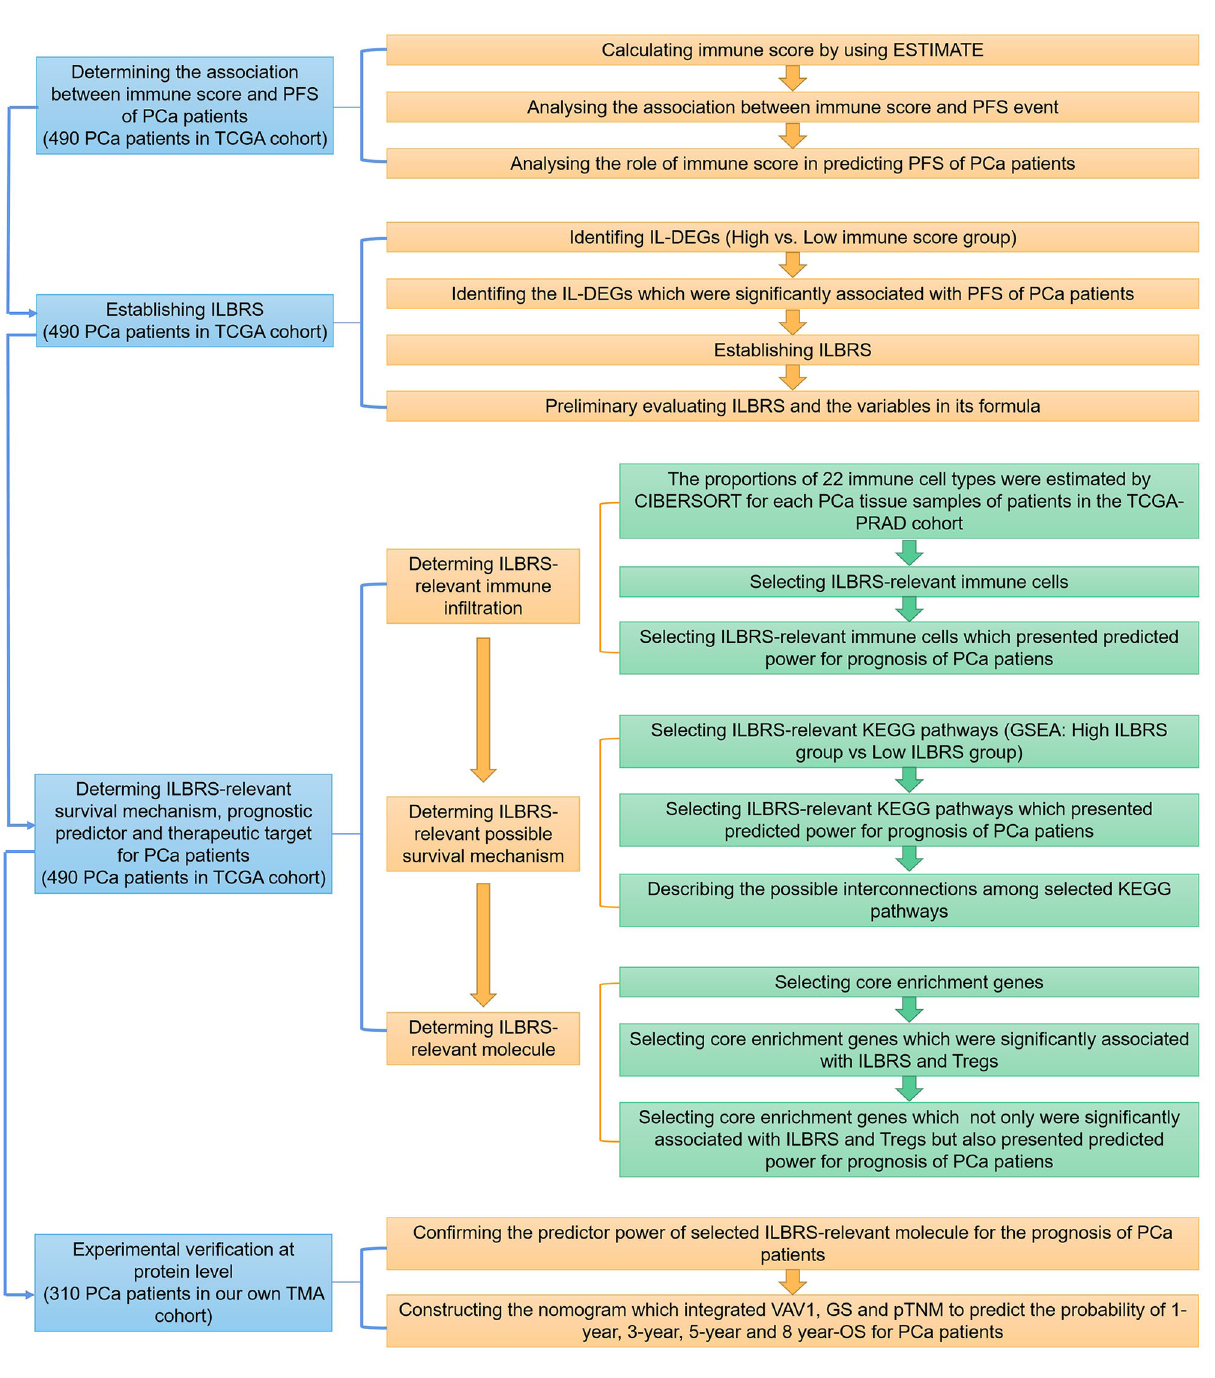
Frontiers in Oncology |